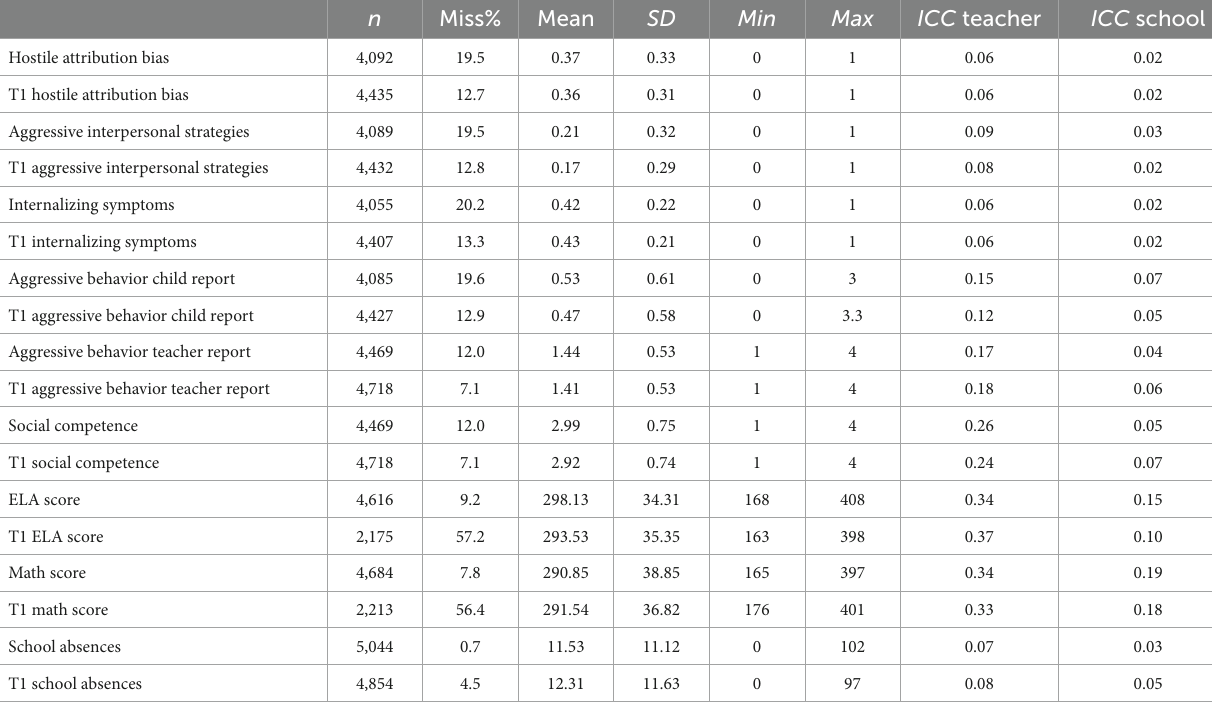
TABLE 5 Descriptive statistics of child